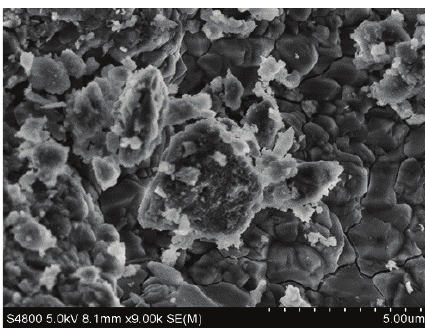
Figure 1: SEM images of Ce-Al-Fe trimetal oxide adsorbents (Al/Fe/Ce molar ratio = 1: 2: 0.5).